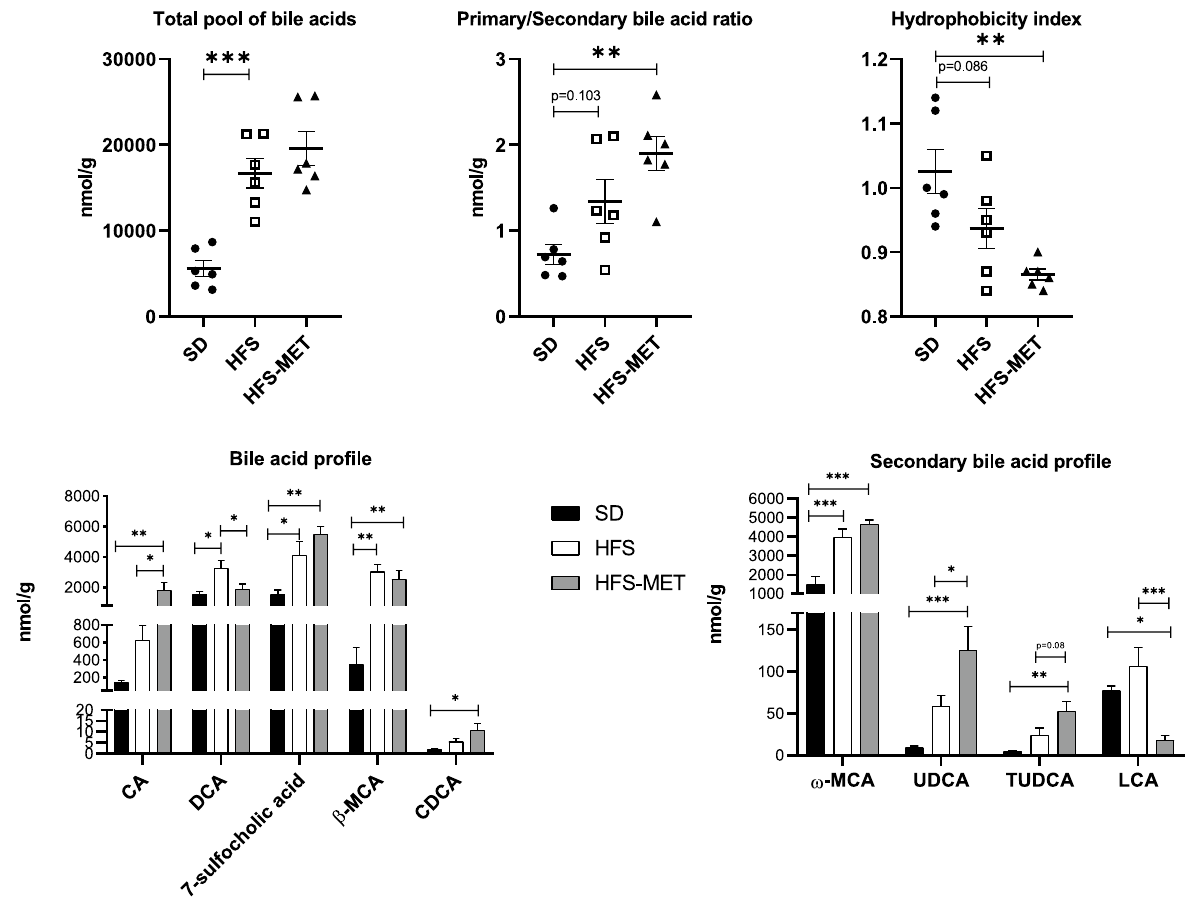
Figure 5. Metformin treatment impacts bile acid pool in the ceacum of the mice. Bile acid molecular species concentrations were measured by HPLC coupled to tandem mass spectrometry (HPLC–MS/MS) in caecum of 6 mice per group ( SD standard diet, HFS high fat high sucrose diet, HFS-MET HFS diet with metformin supplementation). *p < 0.05, **p < 0.01, ***p < 0.001, determined by ANOVA followed by Tukey’s multiple comparison